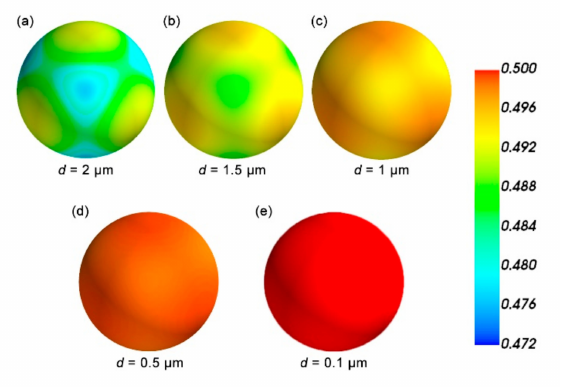
Figure 3. Three-dimensional polar diagram of the e ff ective Poisson’s ratio ν (a = 37.3 µ m, D = 2 µ m). The length of the vector from the origin to the surface is proportional to the modulus of Poisson’s ratio. The small diameter d has been used as parameter: ( a ) d = 2 µ m, ( b ) d = 1.5 µ m, ( c ) d = 1 µ m, ( d ) d = 0.5 µ m and ( e ) d = 0.1 µ